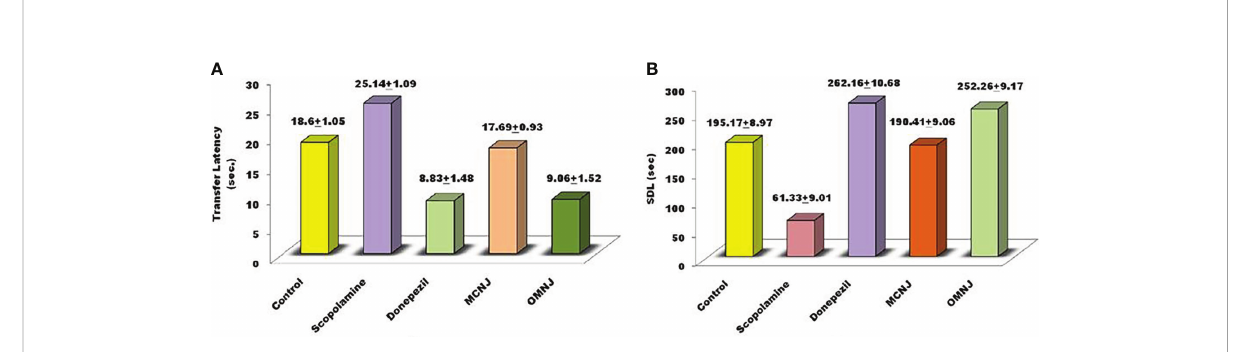
FIGURE 9 Effect of NJ extracts (MCNJ and OMNJ) on behavioral parameters (A) Transfer latency (TL) and (B) . Step down latency (SDL).